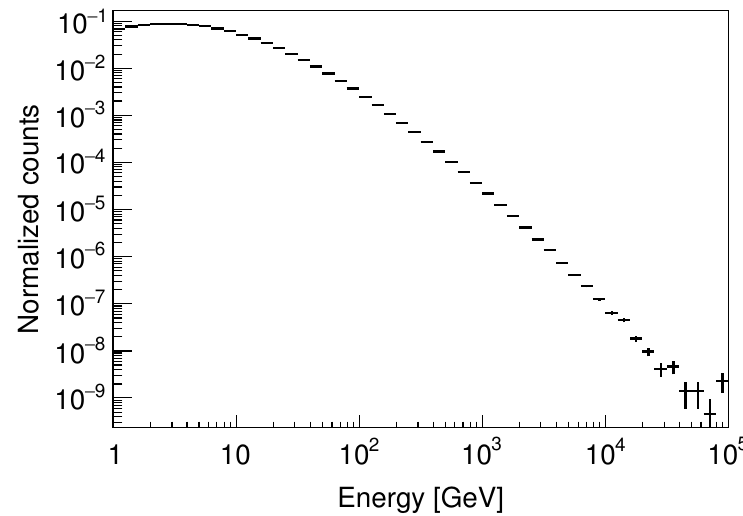
Figure 1. Distribution of sea-level muon kinetic